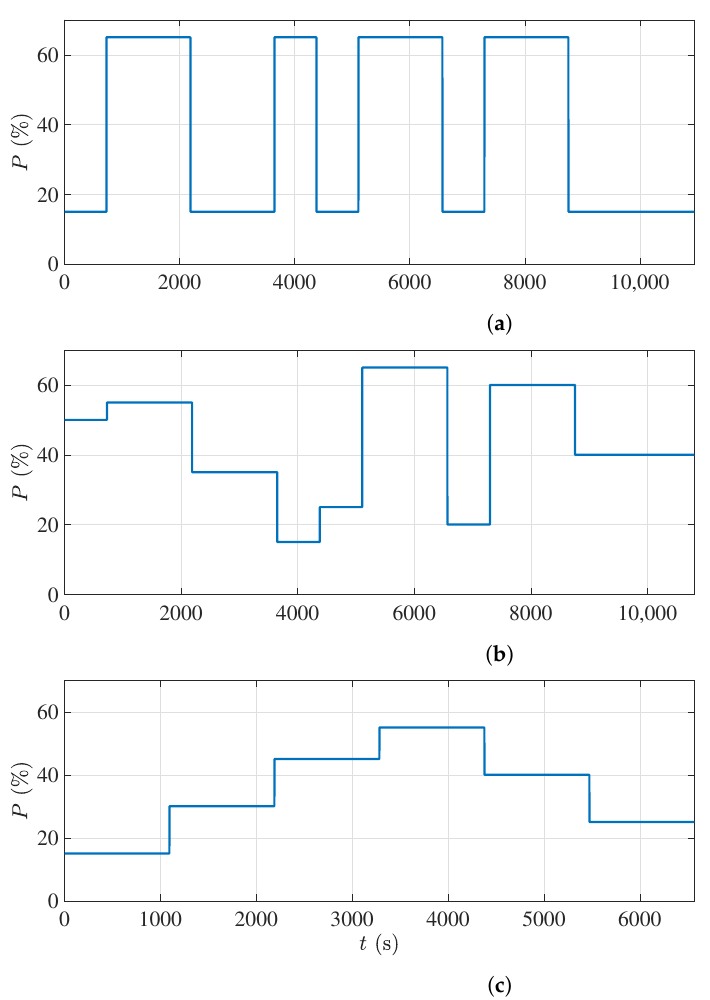
Figure 5. Input signals for the system identification: ( a ) PRBS signal. ( b ) APRBS signal. ( c ) Step signal as